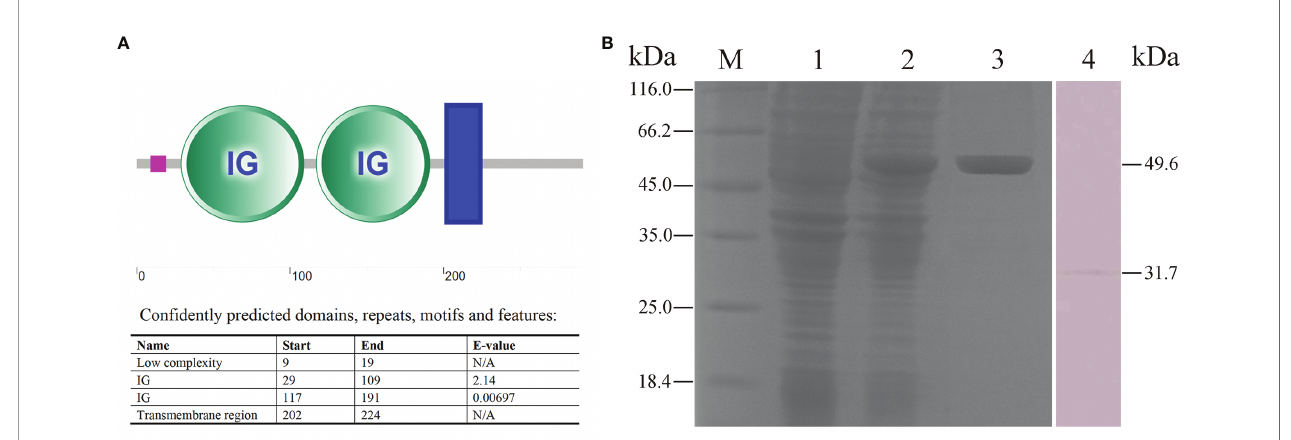
FIGURE 7 | Analysis of Fc g RII recombinant expression and characteristics of anti-rFc g RII antibodies. (A) Analysis of fl ounder Fc g RII domain. The pink line, green circle, and blue box represent the low complexity domain, the IG domains, and the transmembrane region, respectively. (B) SDS-PAGE and western blotting analysis